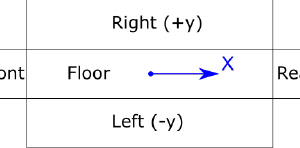
Figure 16. Naming of the cavity surfaces. The side walls are folded